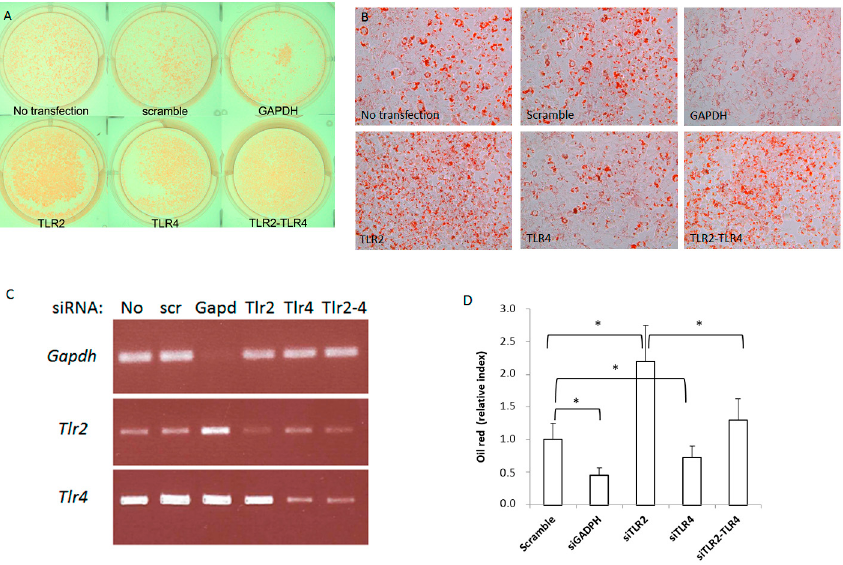
Figure 1. Silencing Tlr2 or Tlr4 gene expression in 3T3-L1 cells results in different adipogenic differentiation outcomes. 3T3-L1 cells were induced to differentiate after siRNA transfection of a scrambled siRNA or specific siRNAs for Gapdh , Tlr4 and Tlr2 or both Tlr2 and Tlr4 . ( A ) Plate photograph of intracellular lipids in 3T3 − L1 cells stained with Oil red O solution. Pictures were taken 5 days after induction of adipogenesis; a representative picture is shown. ( B ) 3T3-L1 cell monolayers were photographed with an inverse phase contrast microscope at a final magnification of 200 × . ( C ) Efficiency of gene expression silencing analysed by RT-PCR (No: no transfection; scr: scramble). ( D ) Quantification of oil red in three independent experiments performed in duplicate (* p < 0.05). Results are expressed as the mean ± standard deviation.